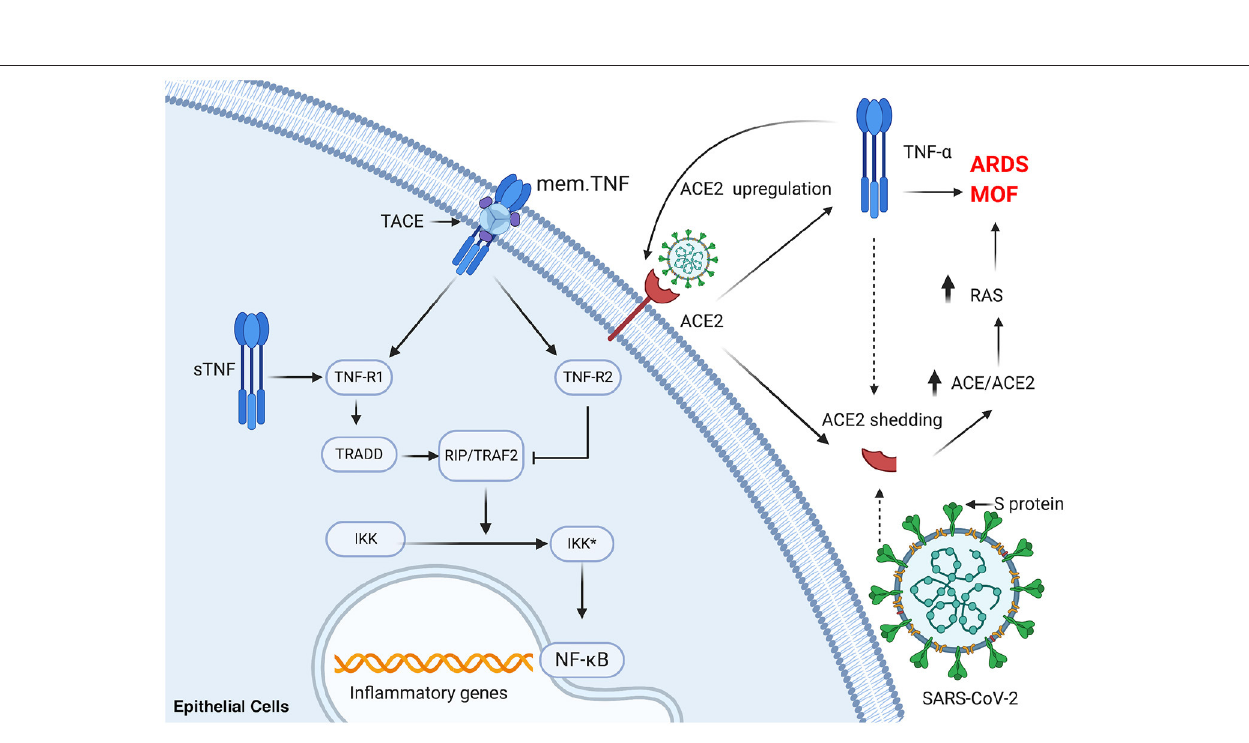
Frontiers in Public Health |